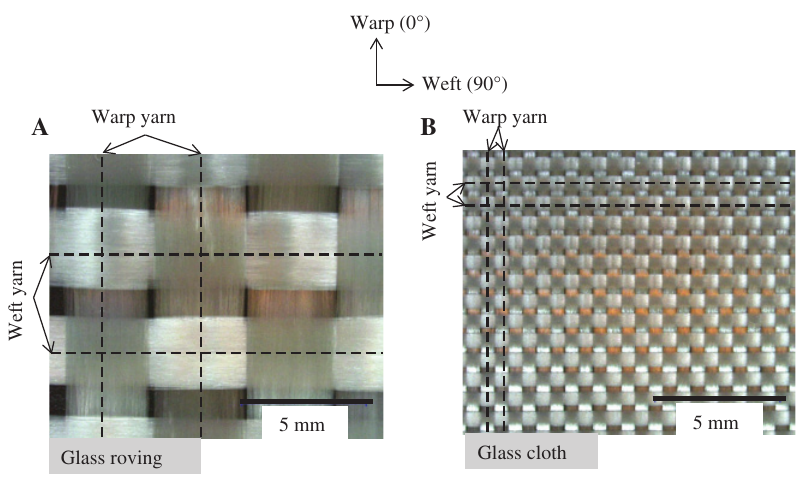
Figure 1 Photographs of woven reinforcement fabrics: (A) glass roving and (B) glass cloth.